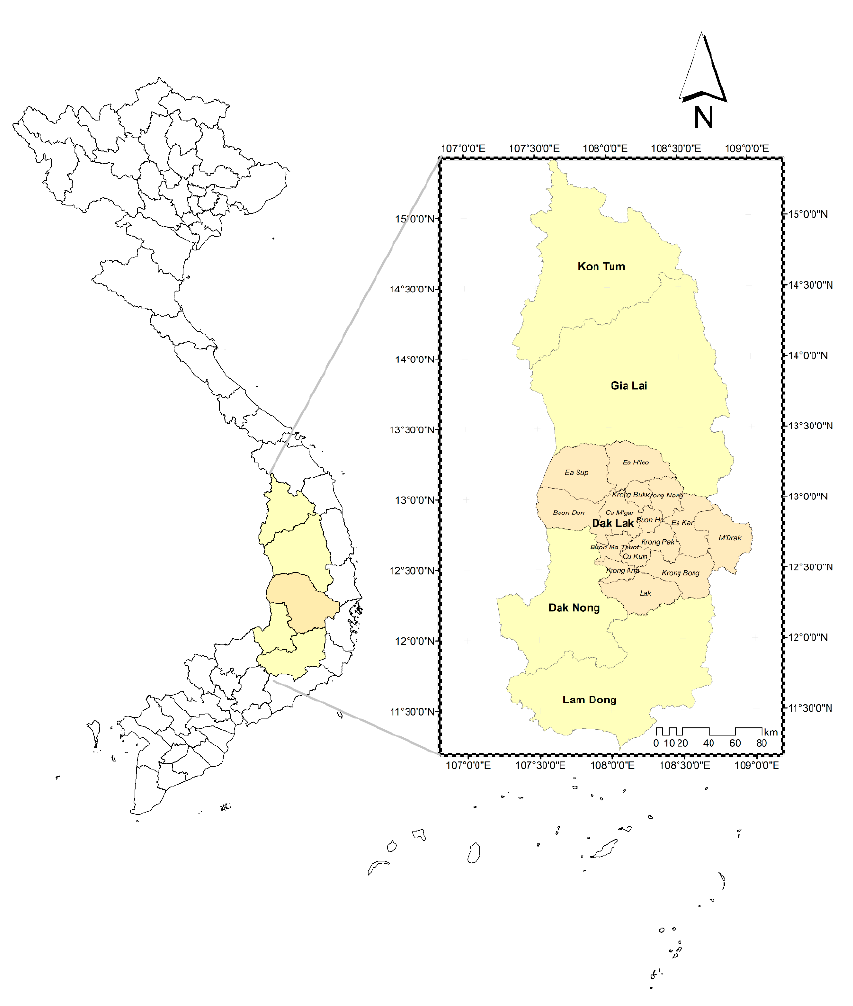
Figure 1. Geographical location of Dak Lak province within the Central Highlands region, Vietnam.